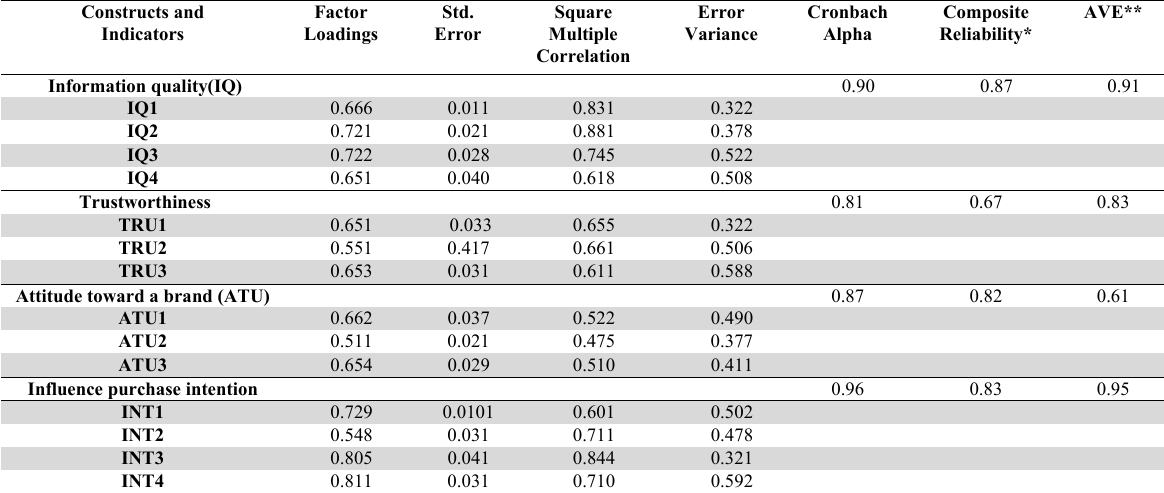
The final measuring model's characteristics